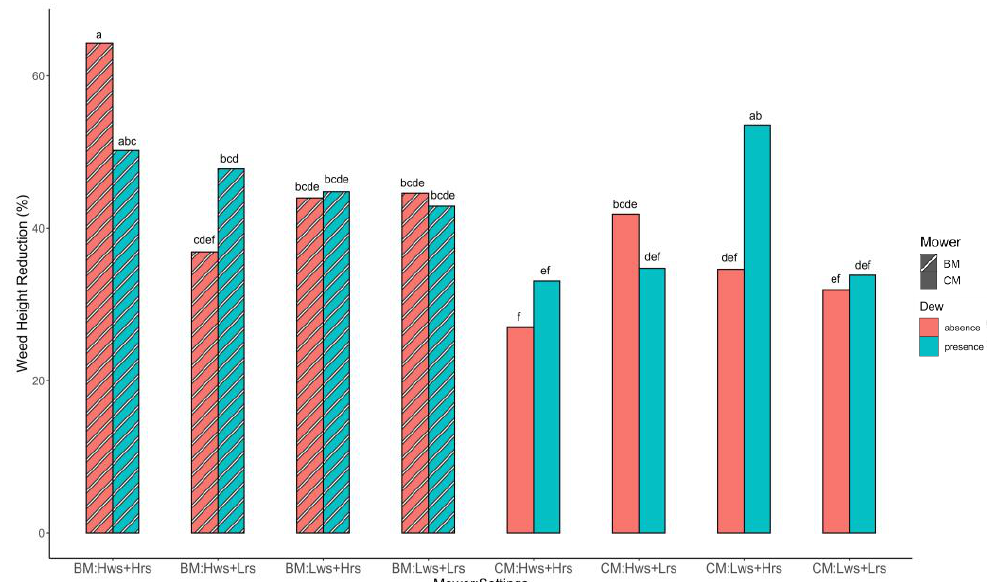
Figure 14. Effect of the interaction between mower version, setting configuration, and dew conditions on weed height reduction. Means denoted by different letters are significantly different at p < 0.05 (LSD test). BM—Blade mower; CM—chain mower; Hws—high working speed; Lws—low working